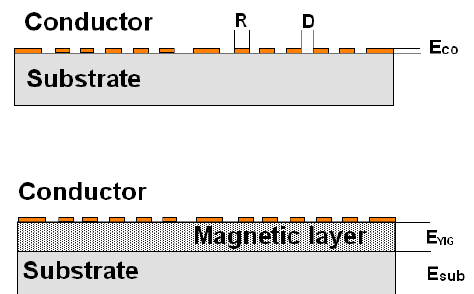
Figure 2: Patterns of spiral inductors with and without magnetic material